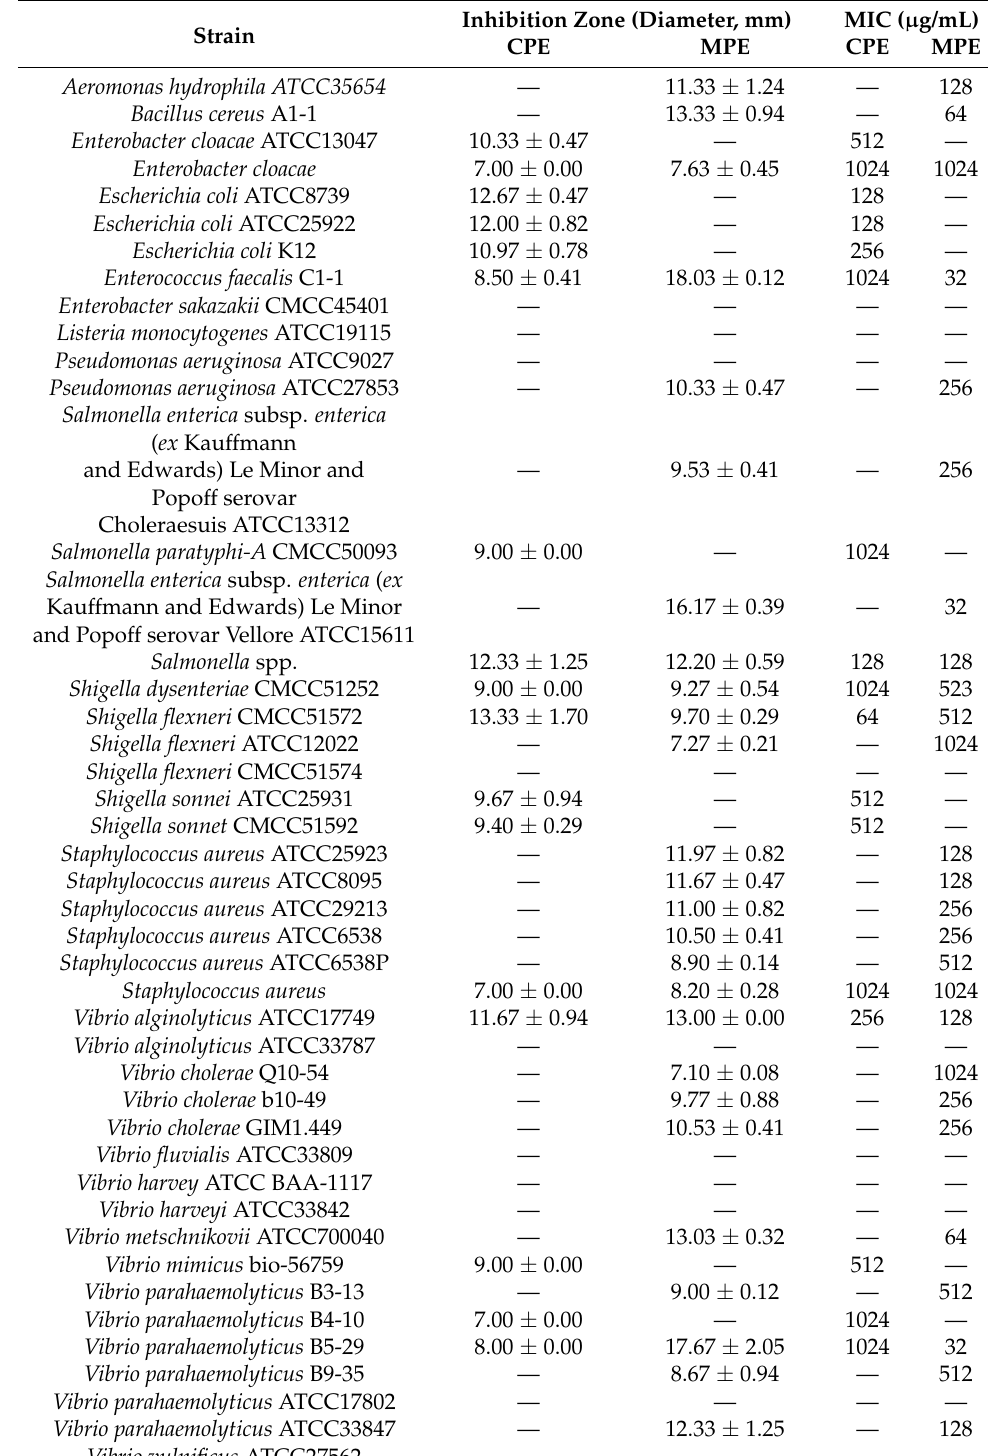
Table 1. Antibacterial activity of the methanol-phase and chloroform-phase crude extracts from C. communis Linn. Strain